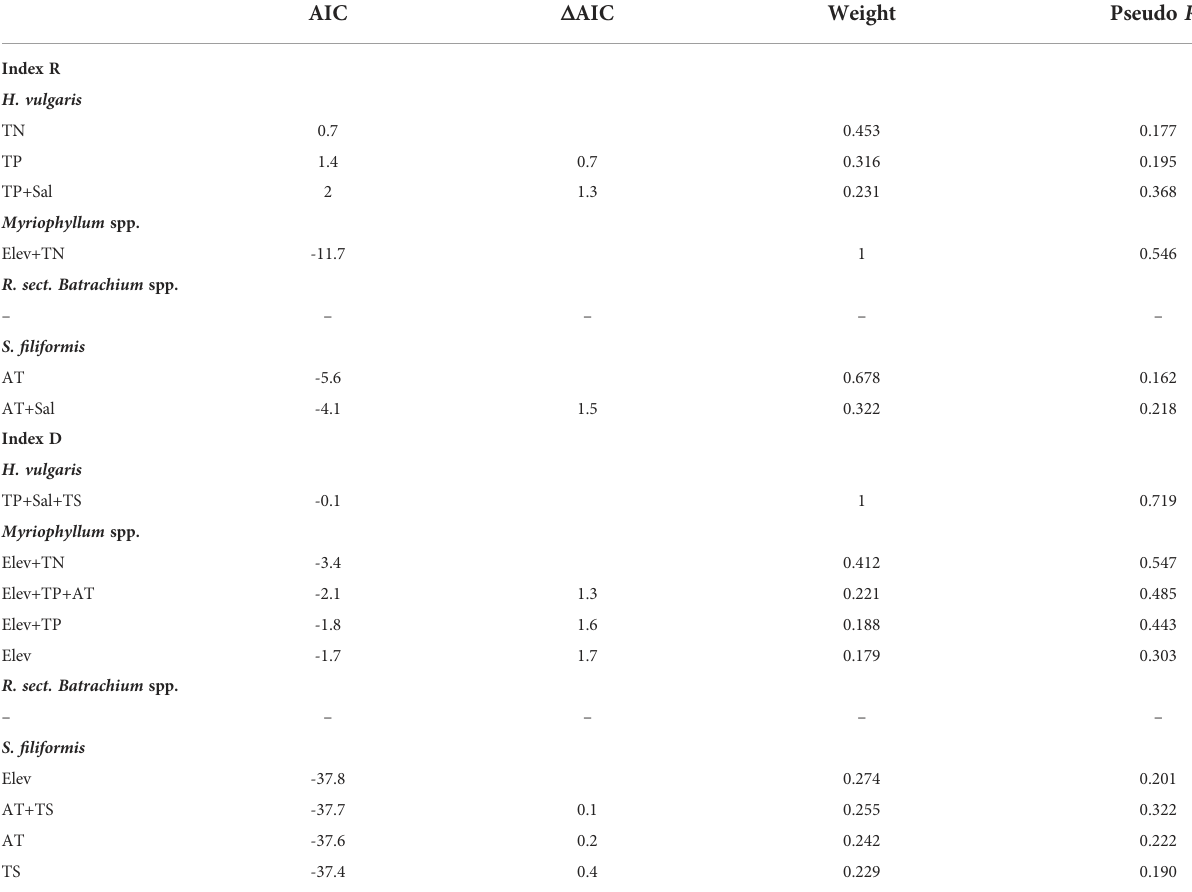
TABLE 2 Summary of best models explaining variation in clonal diversity of four aquatic plant taxa on the Qinghai-Tibetan